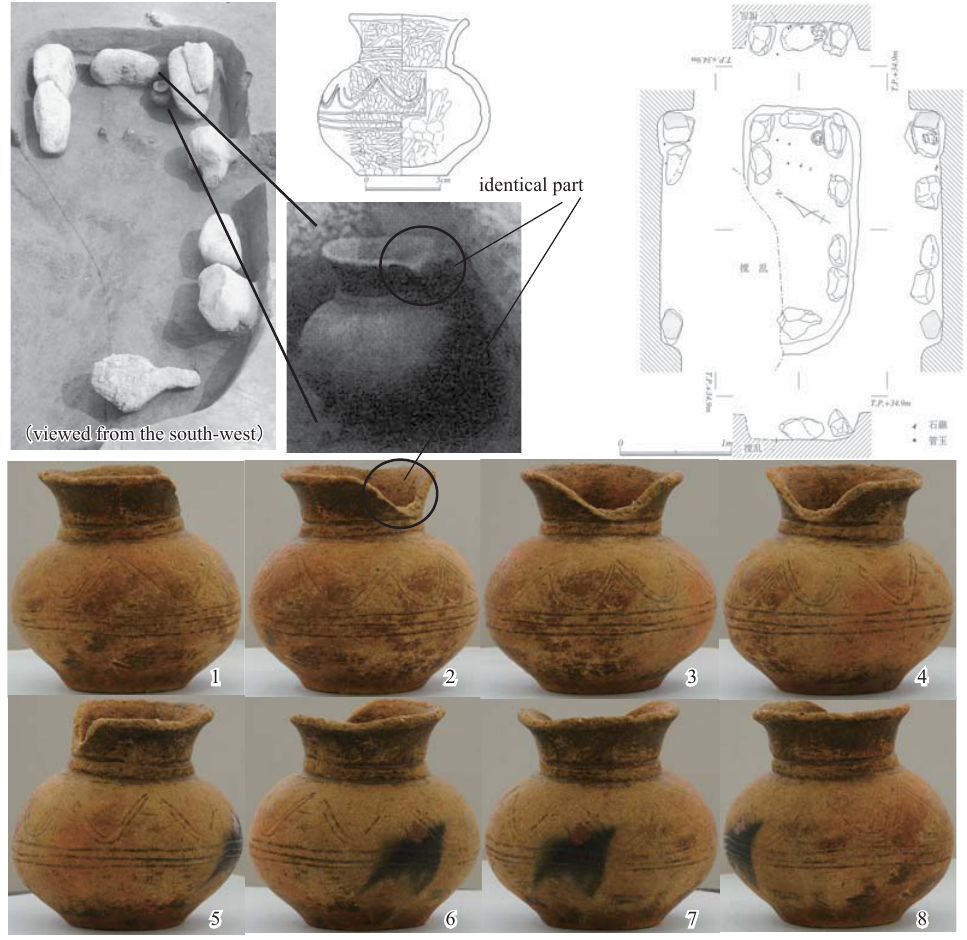
Figure 4. A sample of the collation analysis of photographs in the case of an offering vessel, in this case no.11 in pit-grave SK11. The offering vessel found at the eastern corner was in a standing position, with its fire-cloud facing the north-eastern side wall. The orientation of the fire-cloud is evident from the collation of the context photo with the omni-directional photos taken at eight different